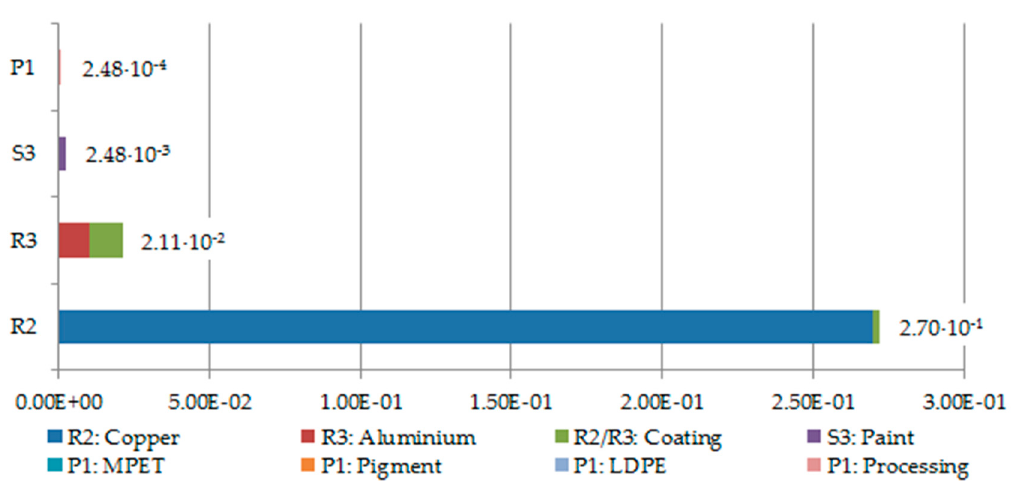
Figure 5. Comparison of the summed normalized environmental impacts of the developed absorber P1 with S3 paint and R2 and R3 TiNOx absorbers (per 1 m 2 ).